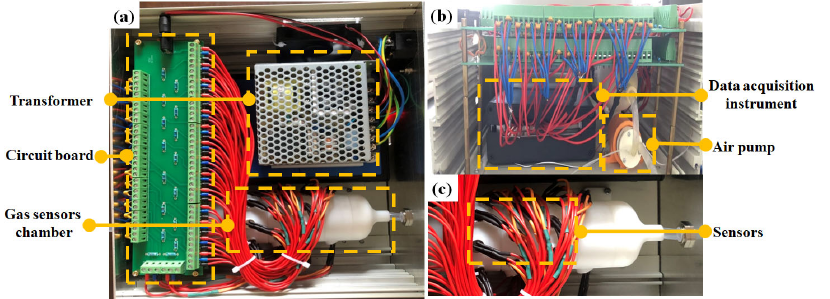
Figure 2. The structure of e-nose system. ( a ) Vertical view of e-nose, ( b ) left view of e-nose, ( c ) enlarged view of the gas sensors chamber.